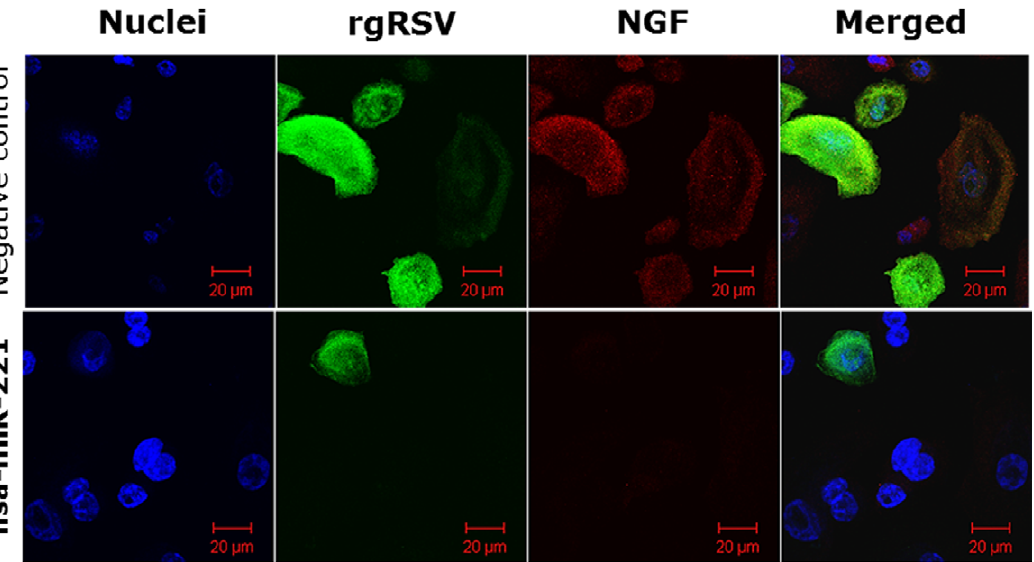
Figure 6. Confocal microscopy of RSV-infected cells. After 24 h infection with rgRSV, most of the bronchial epithelial cells transfected with negative control miRNA (top panels) showed strong green fluorescence as a result of active rgRSV infection and concomitant red fluorescence upregulation of NGF expression. In contrast, NGF expression was silenced in bronchial epithelial cells overexpressing hsa-miR-221 (bottom panels), and this effect was associated with a sharp reduction in the number of cells displaying green fluorescence. Bar scale=20 m m.